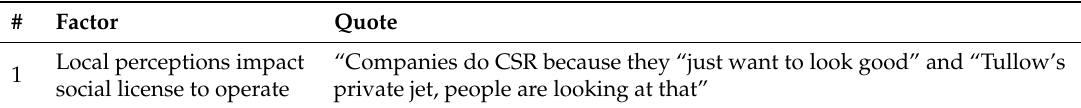
Table 10. ‘Local community engagement’ theme.